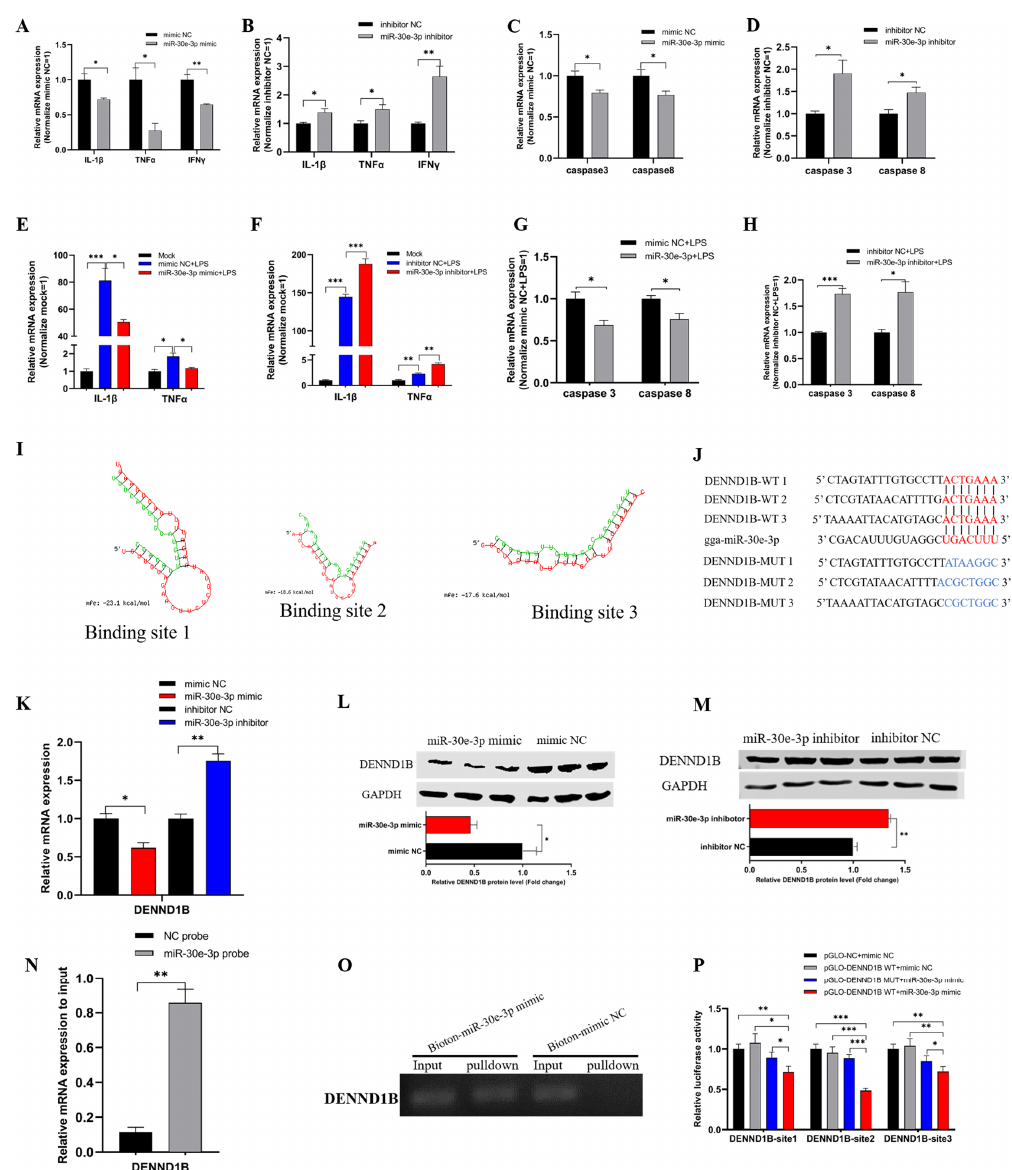
Figure 3. The gga-miR-30e-3p suppresses inflammation and apoptosis. ( A , B ) Mir-30e-3p suppressed the mRNA expression levels of pro-inflammatory factors. ( C , D ) Mir-30e-3p suppressed the mRNA expression of pro-apoptosis maker genes. ( E , F ) The expressions of pro-inflammatory factors were down-regulated by miR-30e-3p in HD11 exposed to LPS. ( G , H ) The mRNA expressions of pro-apoptosis maker genes were down-regulated by miR-30e-3p in HD11 exposed to LPS. ( I ) MiR-30e-3p matched three binding sites in 3 (cid:48) UTR of DENND1B. ( J ) The potential binding site sequence (were highlighted in red) of miR-30e-3p on 3 (cid:48) UTR of DENND1B. ( K , M ) Mir-30e-3p suppressed both mRNA and protein expression levels of DENND1B. ( N ) The enrichment of DENND1B in the biotinylated miR-30e-3p mimics pull-down RNA. ( O ) The qRT-PCR products of DENND1B in pull-down RNA. ( P ) Dual-luciferase assay verified the binding relationship between DENND1B and miR-30e-3p. Data are presented as mean ± SEM (n ≥ 3 biologically independent samples). * p < 0.05; ** p < 0.01; *** p < 0.001 (Student’s t